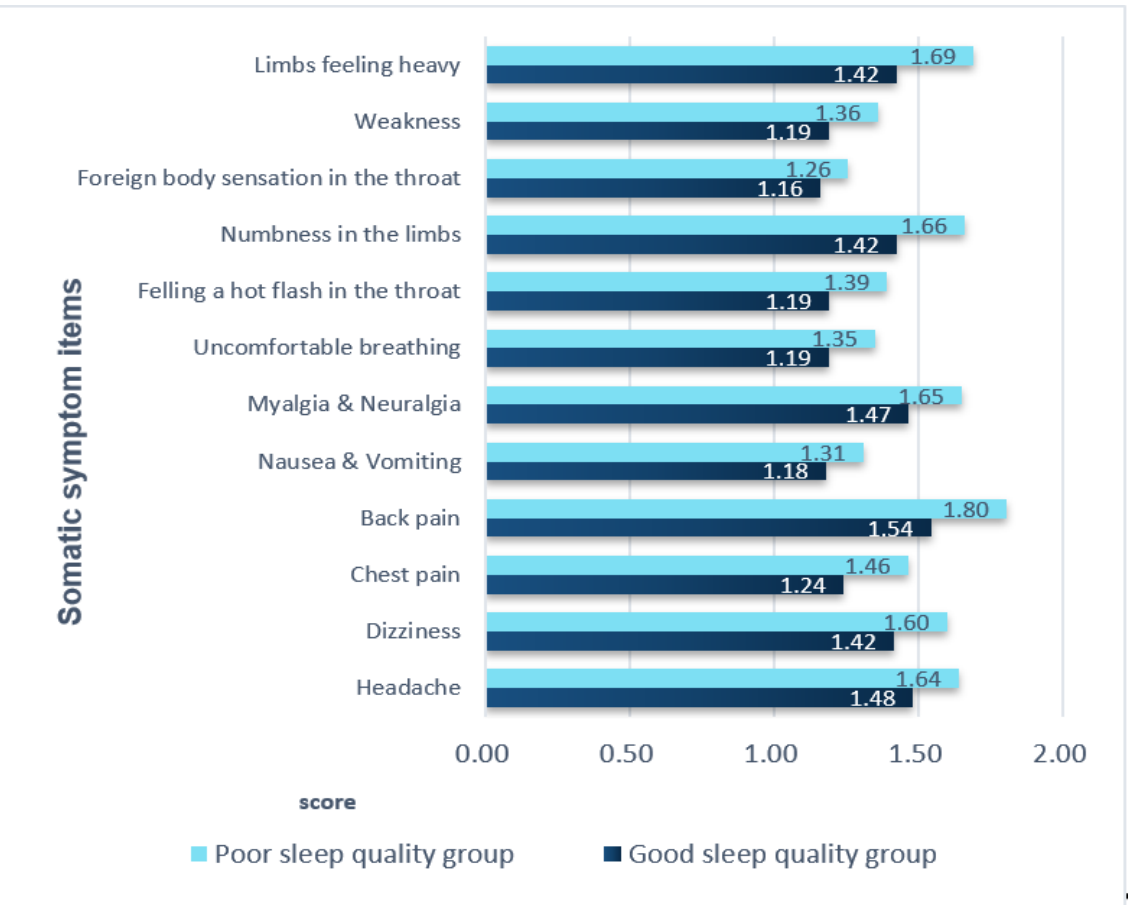
Figure 1. Comparison of somatic symptoms in the two groups. All variables except for the variable of foreign body sensation in the throat had p -values < 0.05 (range: 0.000–0.031). For the variable ‘foreign body sensation in the throat’, the p -value was p = 0.088.